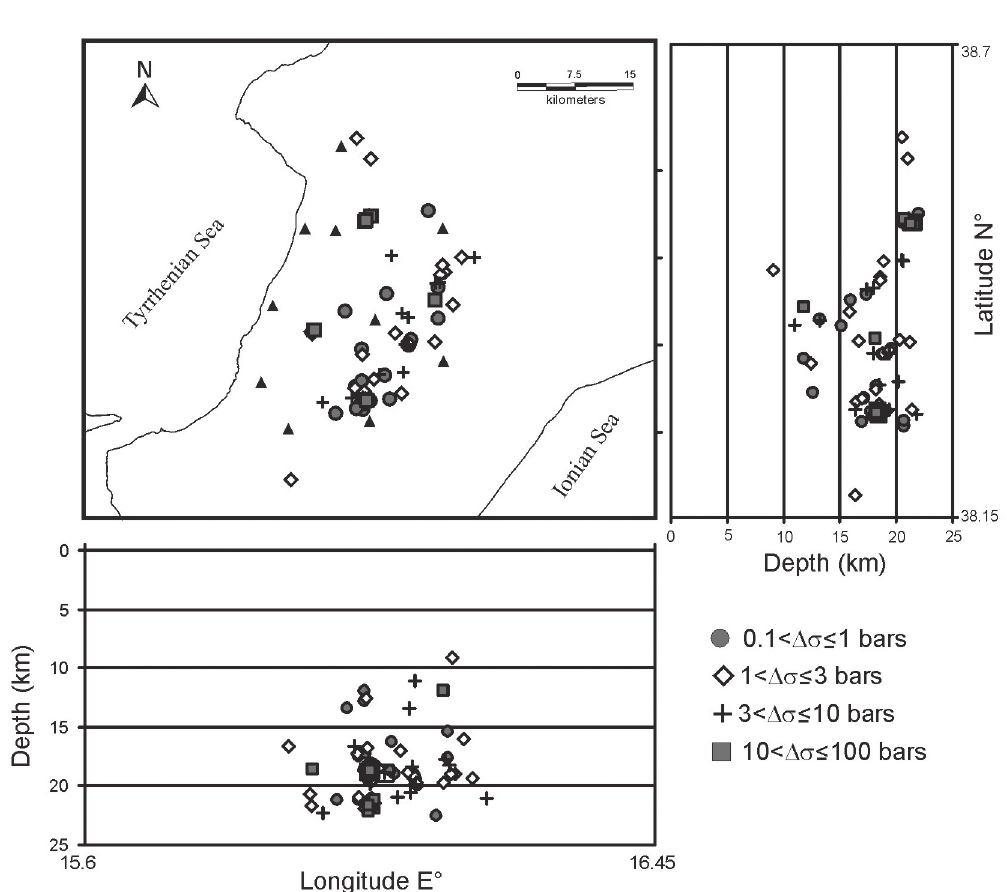
Fig. 8. Map and cross sections showing the spatial distribution of stress drop for the analysed